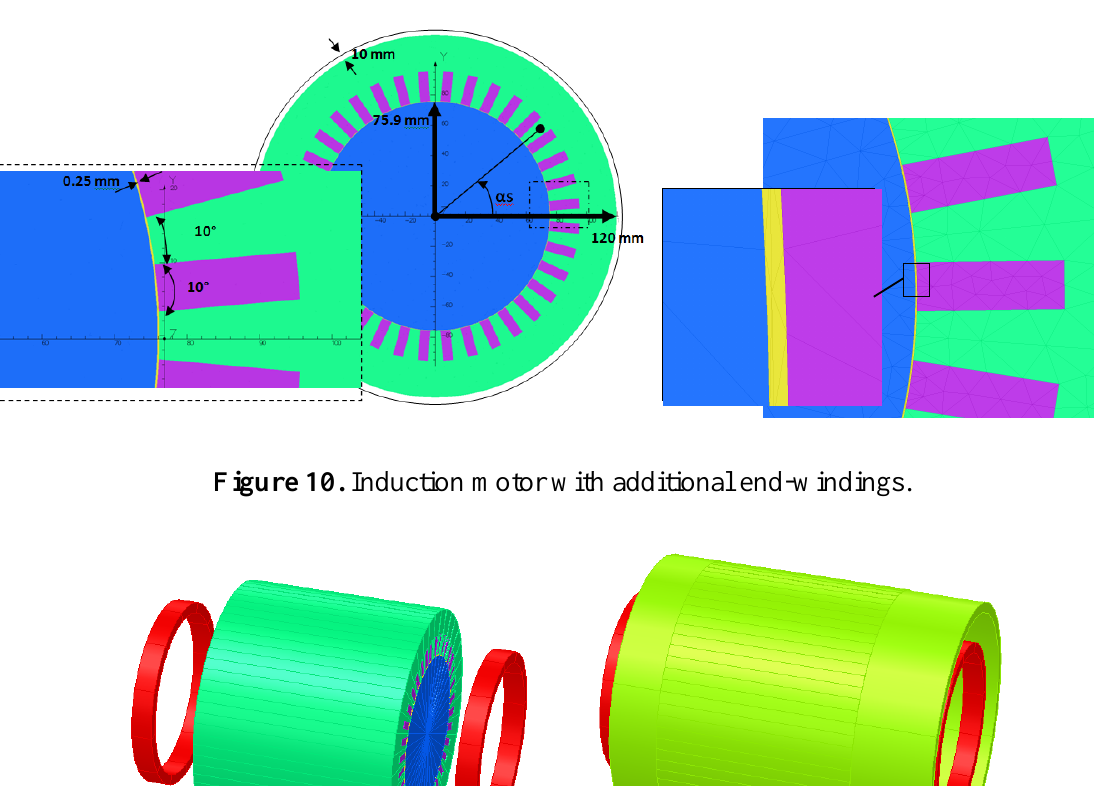
Figure 9. Motor EF 3D geometry and mesh.